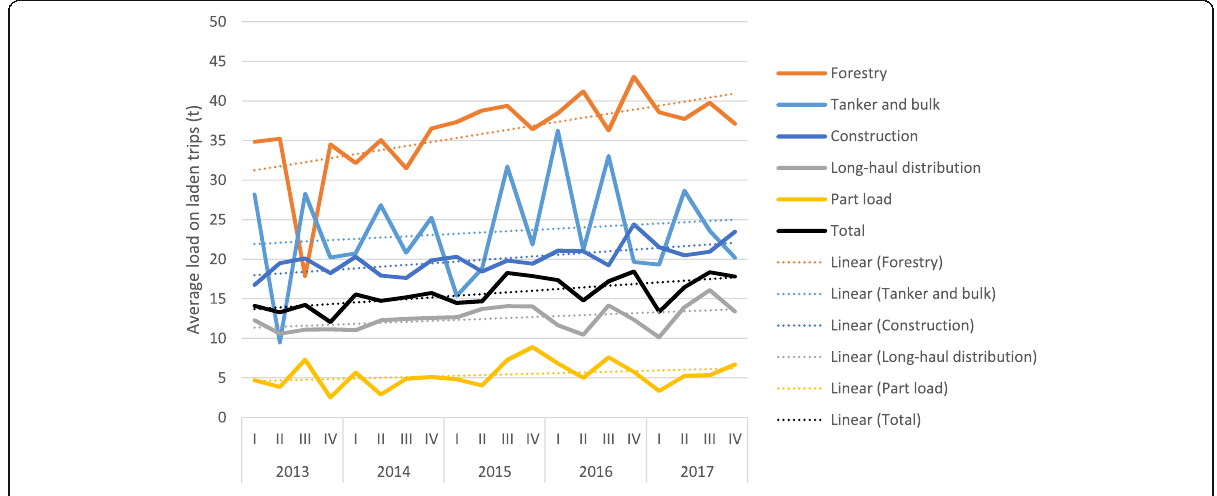
Fig. 2 Average payload weight on laden trips by vehicle type quarterly from 2013 to